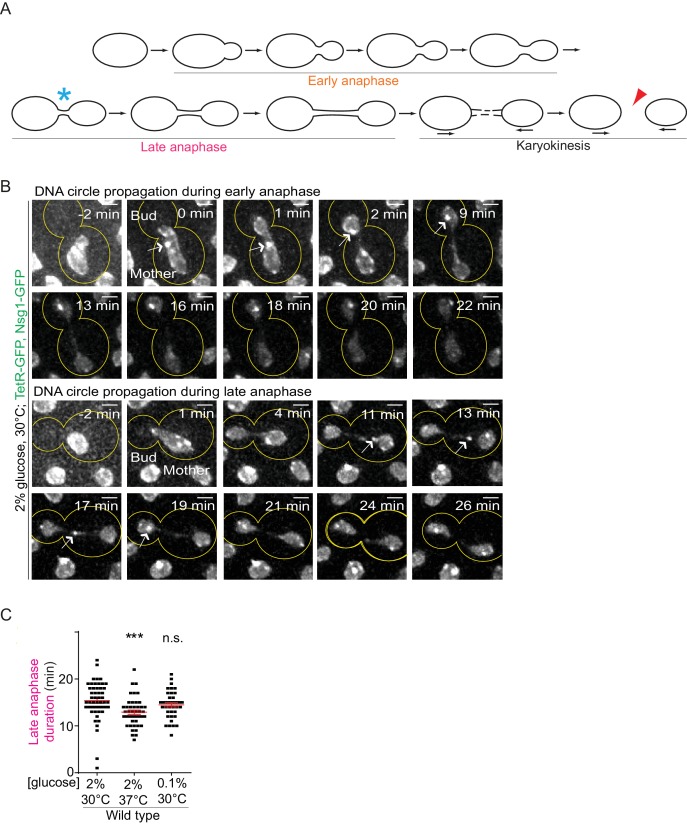
Changes in early or late anaphase duration cannot explain DNA circle segregation upon heat stress.A) Schematic definition of anaphase stages, see text for details. (B) Dividing nuclei showing the followed DNA circle (arrow), during early and late anaphase (maximum intensity projection, outline of the cell in yellow, scale bar is 1 µm). Bright dots represent either DNA circles or, if at the opposite sides of the nucleus, the SPBs. 0 min was set as the beginning of anaphase (the frame when the nucleus starts entering into the bud). (C) Quantification of late anaphase duration (mean ±SEM of two to three independent experiments per condition), 39 ≤ n ≤ 50 cells per condition. Non-parametric Mann-Whitney U test: **p<0.01.